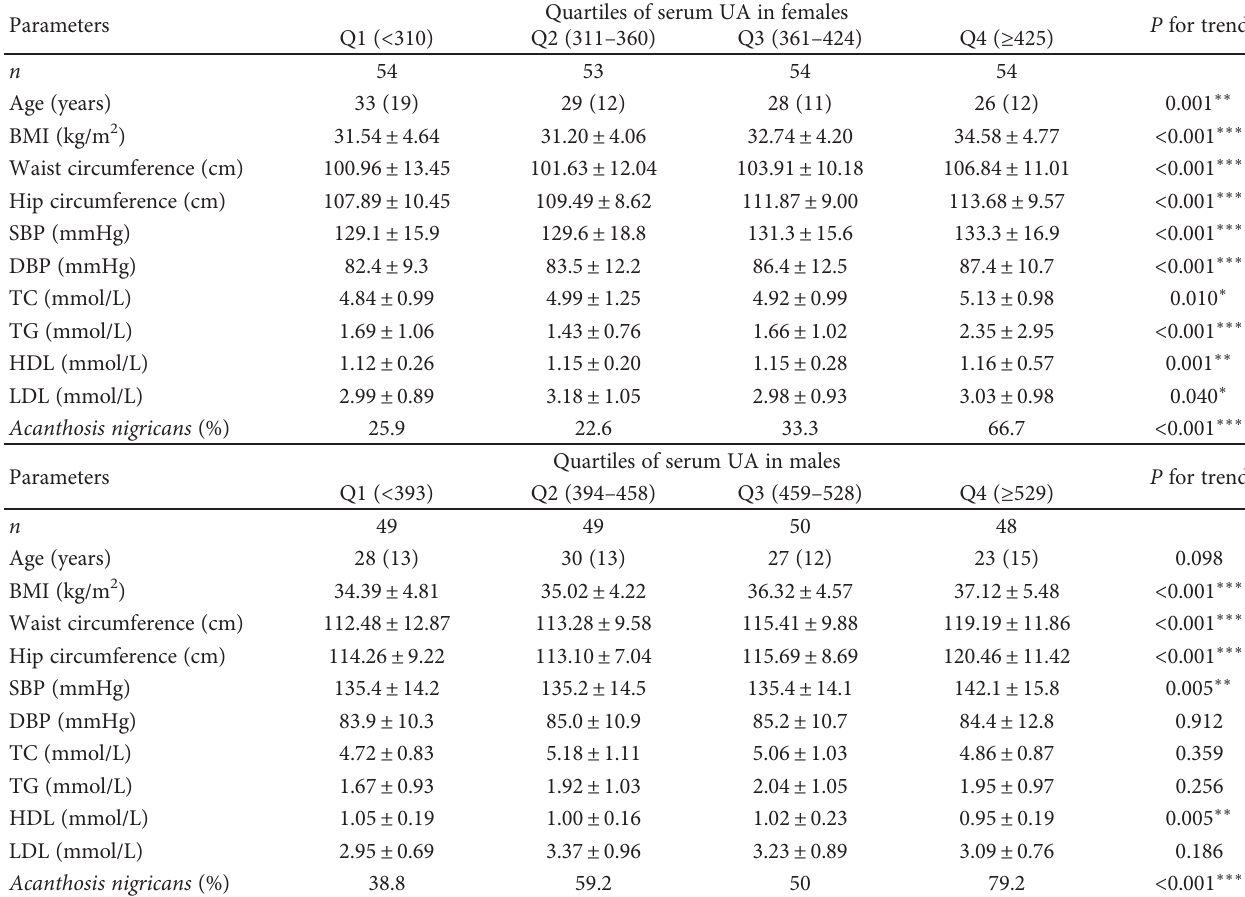
Table 2: Characteristics of participants according to serum UA quartiles in females and